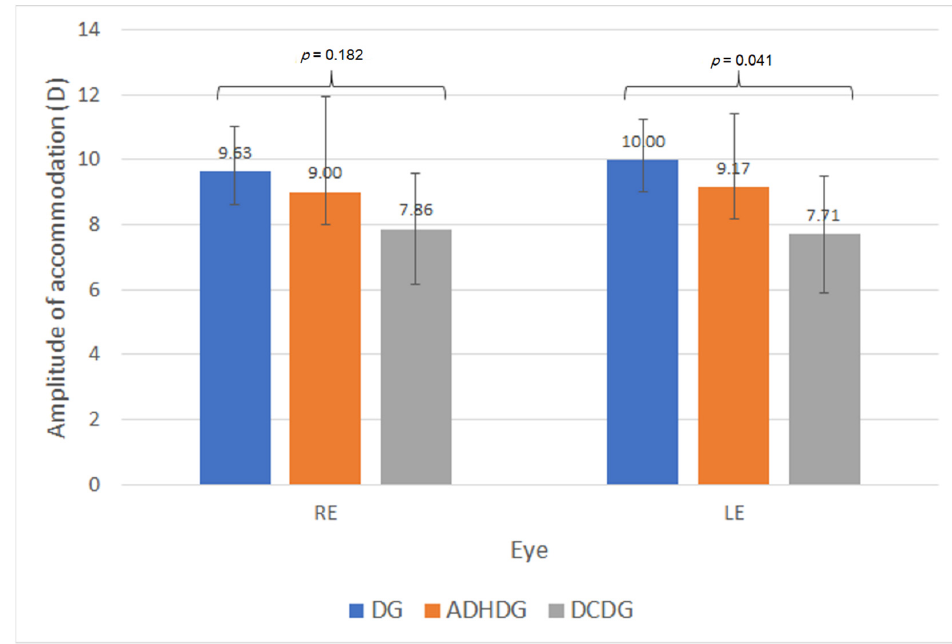
Figure 1. Mean amplitude of accommodation of the right (RE) and left eye (LE) in the subgroups of dyslexia (DG), attention deficit/hyperactivity disorder (ADHDG) and developmental coordination disorder (DCDG).